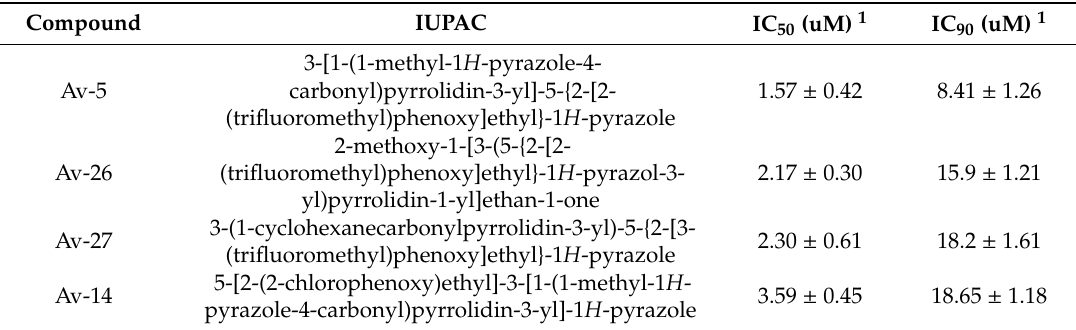
Table 1. Avirulin lead